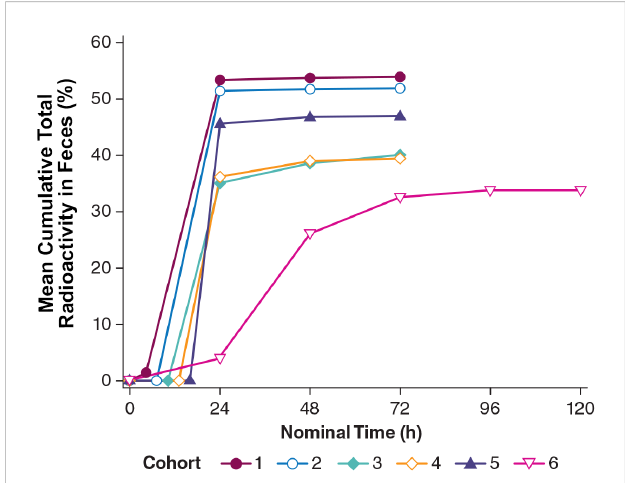
FIGURE 13 Total radioactivity in feces excreted by healthy humans across cohorts from the phase 0 clinical study. Cohort 1 = [ 14 C]-PL8177 + laxative 5 h postdose; Cohort 2 = [ 14 C]-PL8177 + laxative 8 h postdose; Cohort 3 = [ 14 C]-PL8177 + laxative 11 h postdose; Cohort 4 = [ 14 C]-PL8177 + laxative 14 h postdose; Cohort 5 = [ 14 C]-PL8177 + laxative 17 h postdose; and Cohort 6 = [ 14 C]-PL8177 without